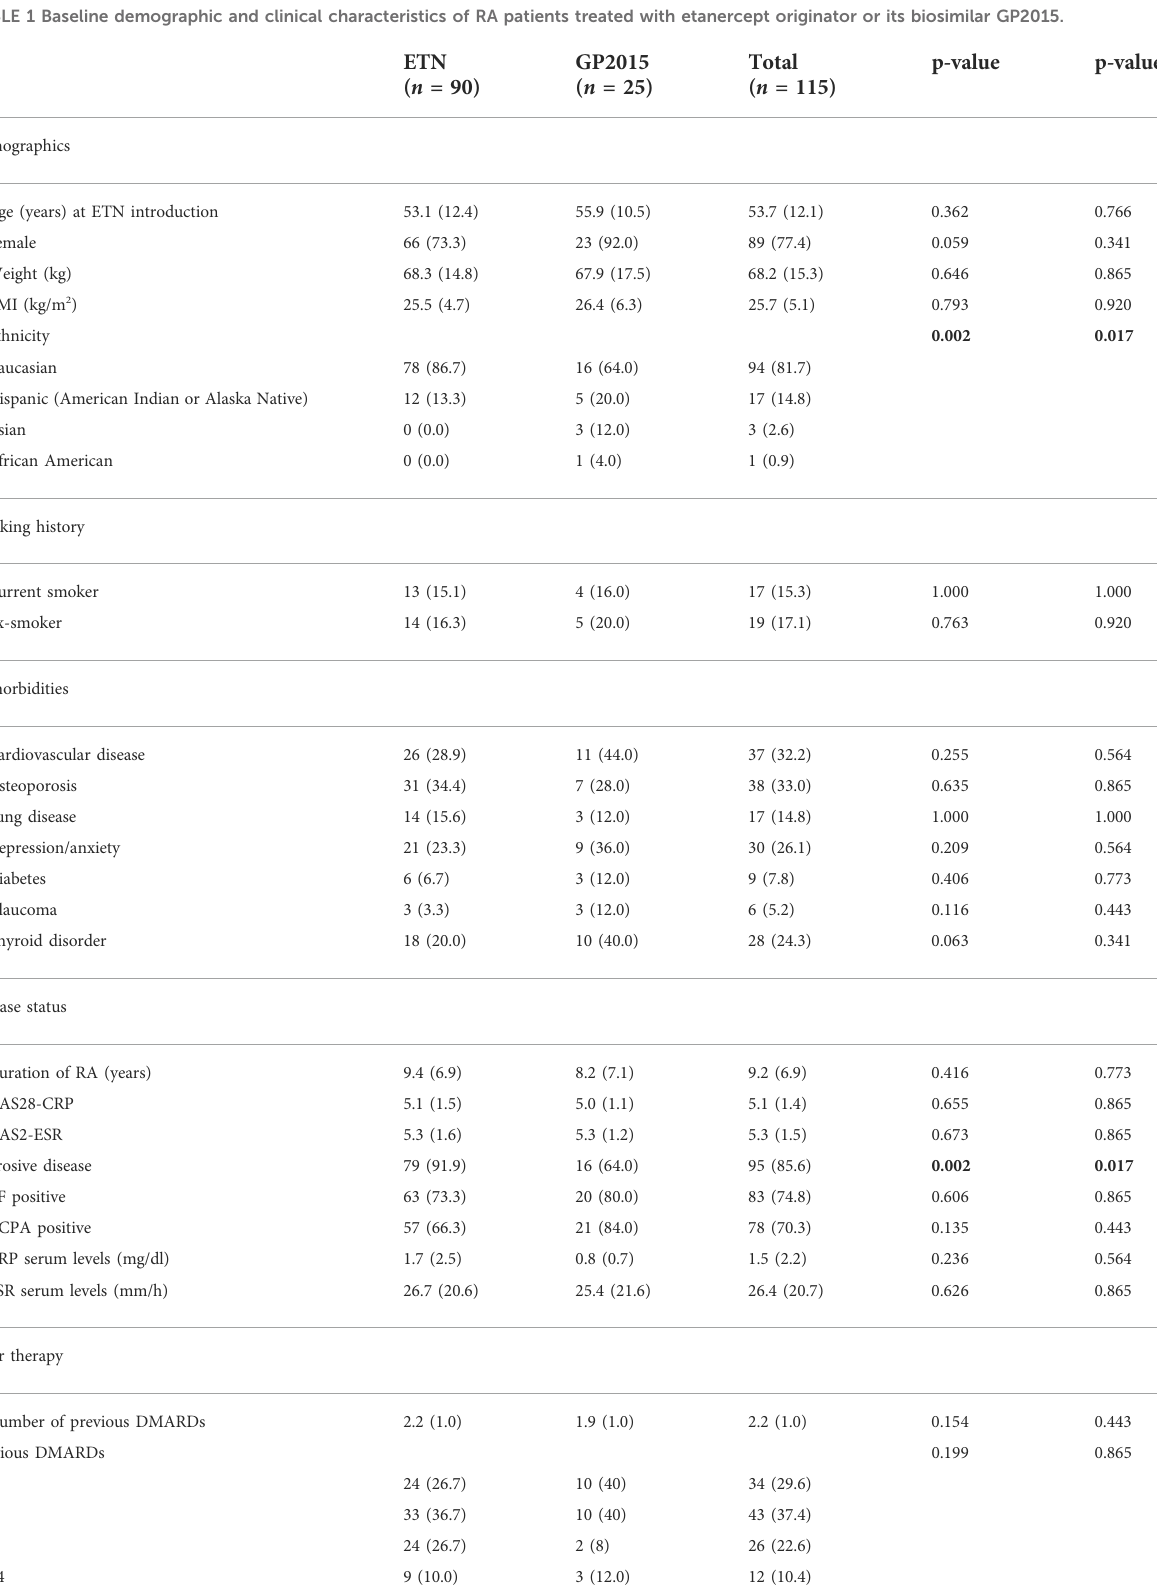
TABLE 1 Baseline demographic and clinical characteristics of RA patients treated with etanercept originator or its biosimilar